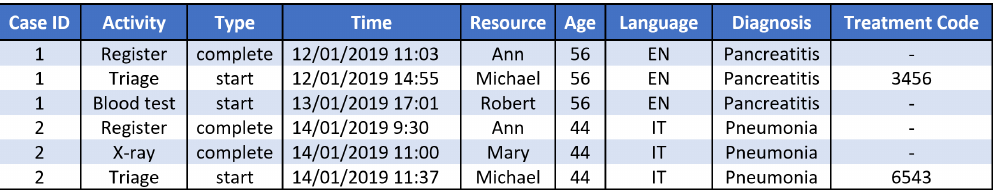
Figure 1. Example of an event log with typical healthcare data